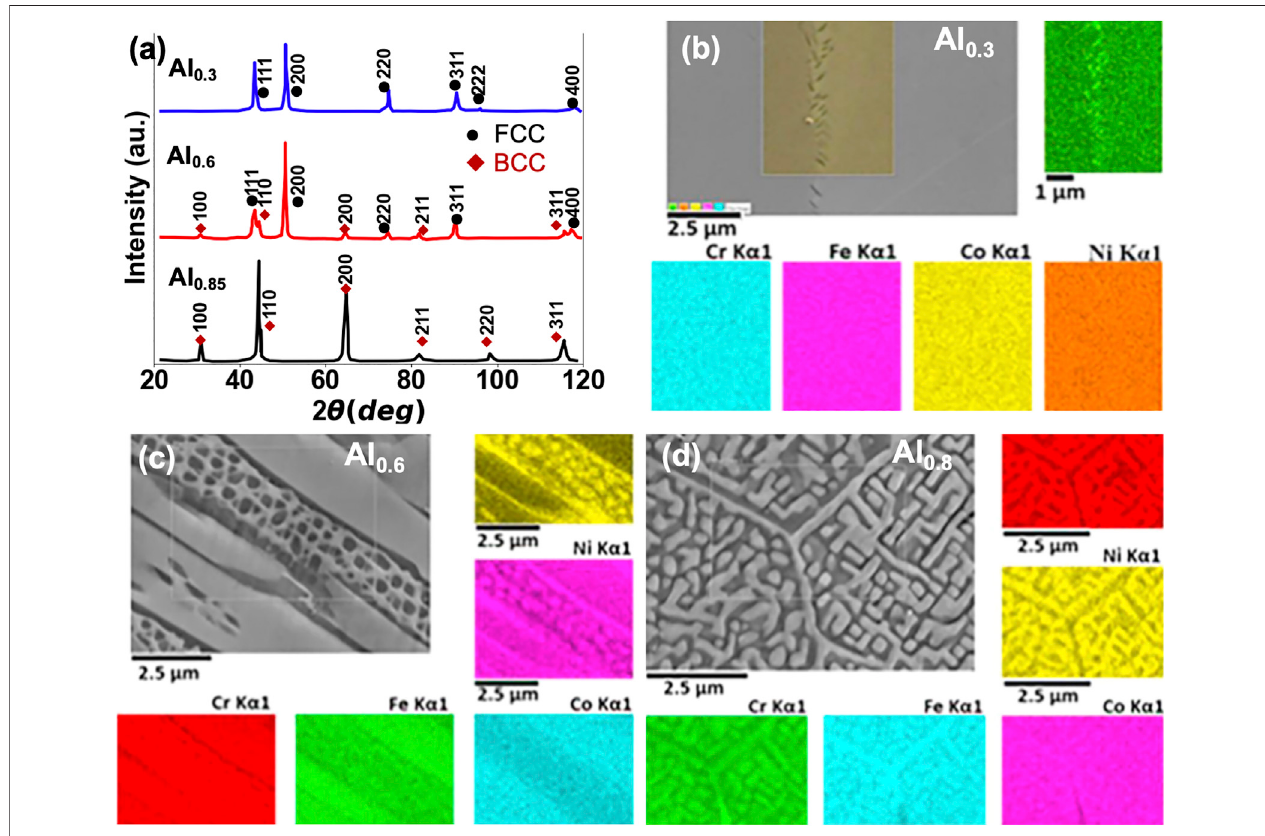
FIGURE 5 | Effect of Al content on the microstructural evolution of Al x CoCrFeNi. (A) XRD plot reveals the realization of multiple phases under varying Al composition, (B) x=0.3:singlephaseFCCsolidsolutionwithAlsegregationalongthegrainboundariesandhomogenousdistribution ofcandidateelementsinthealloy, (C) x=0.6:duplexFCC+BCC/B2,revealsCr-FerichBCCphasecontainingB2Al-Nirichprecipitates, (D) x=0.8:Singlephaseinvertedmicrostructure,withAl-NirichB2 matrix and Cr-Fe rich BCC precipitates (adopted from (Joseph et al., 2015)).